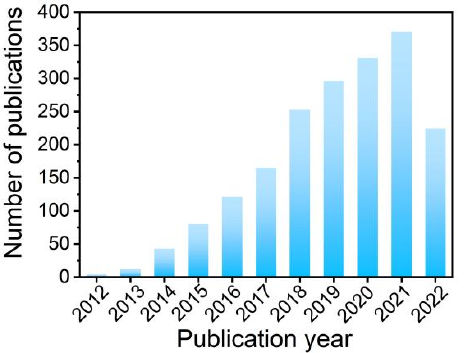
Figure 1. The number of publications on carbon nitride/metal oxide complexes for